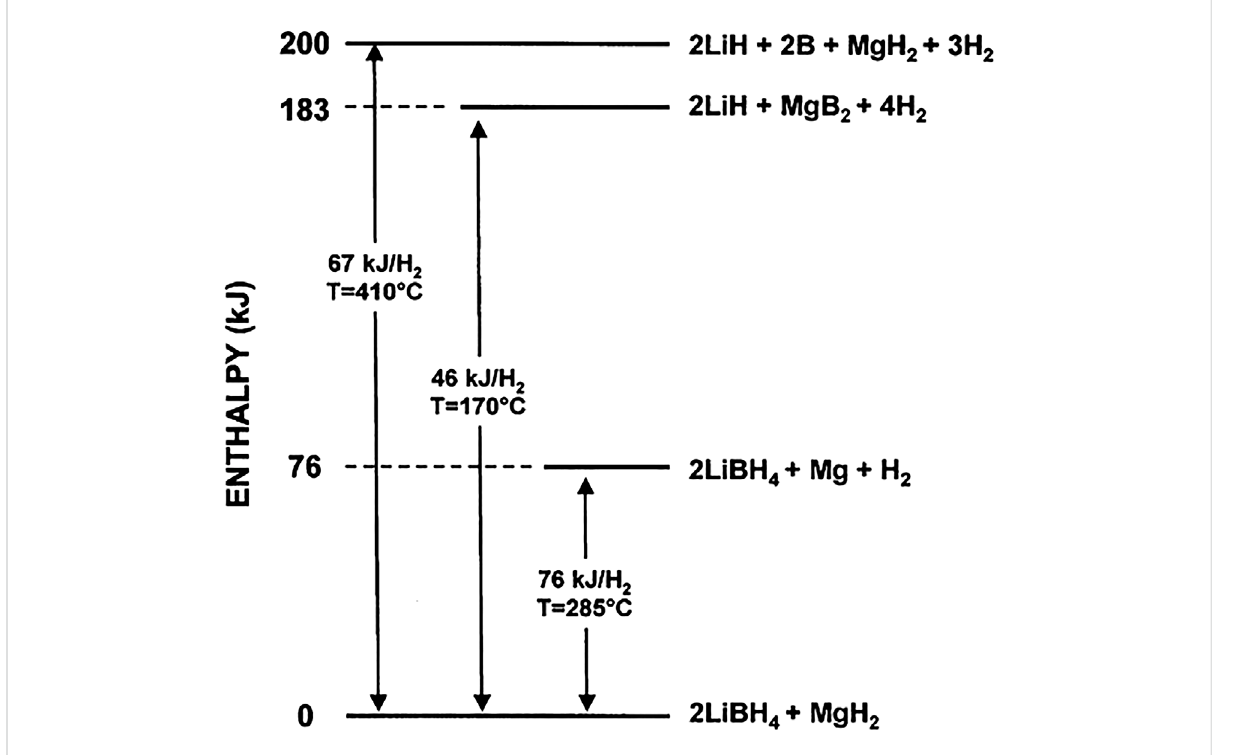
FIGURE 2 Enthalpy change of LiBH 4 -MgH 2 after destabilization (Vajo et al.,